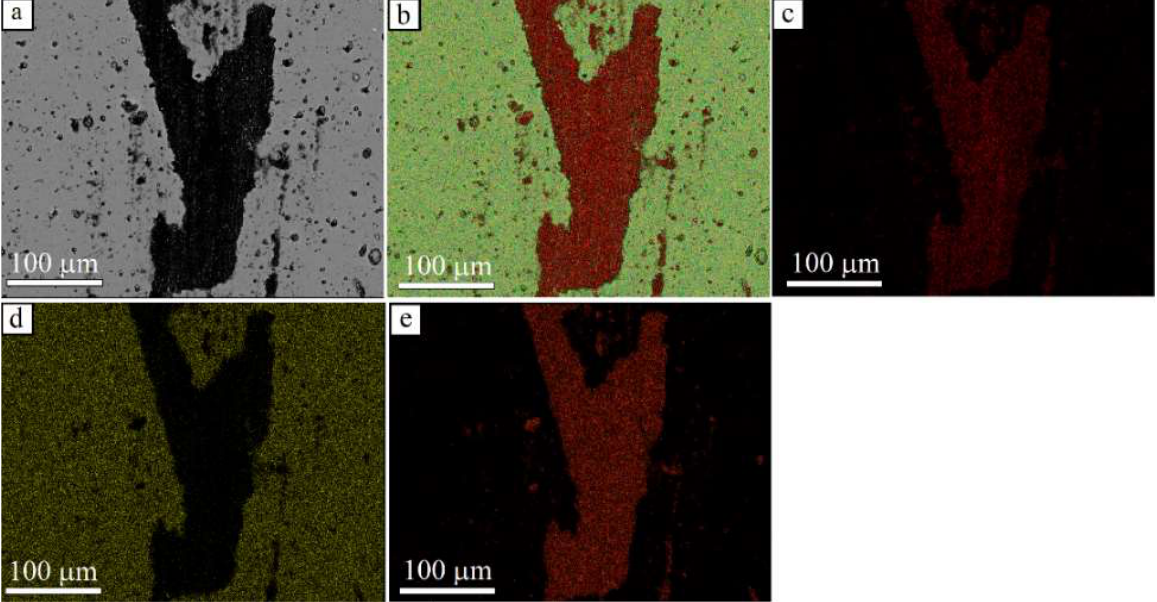
Figure 11. SEM image ( a ) and EDS element distribution maps for Zr, Fe and O ( b ), O ( c ), Zr ( d ) and Fe ( e ) obtained from the worn surface of the ZrN coating after sliding at 1N.